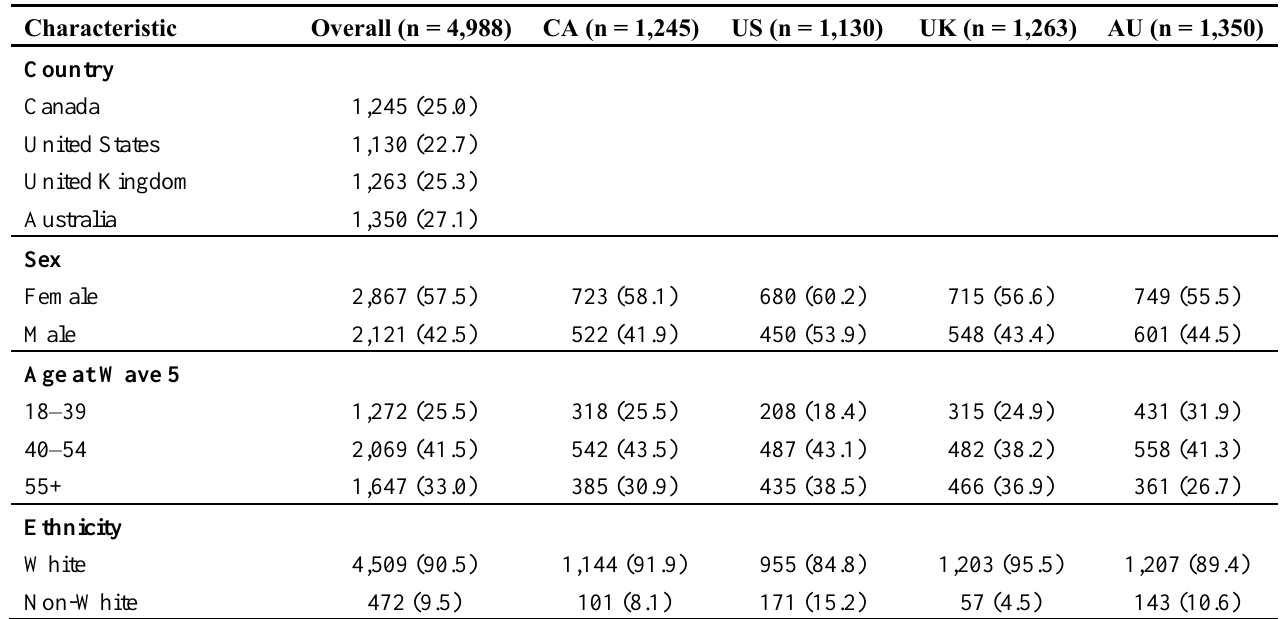
Table 1 . Demographic Characteristics of participants who were current smokers present in waves 5 (main/recruitment) and at wave 6 follow-up, overall (n=4988) and stratified by country (CA: n = 1245; US: n = 1130; UK: n = 1263; AU: n = 1350) (n, %